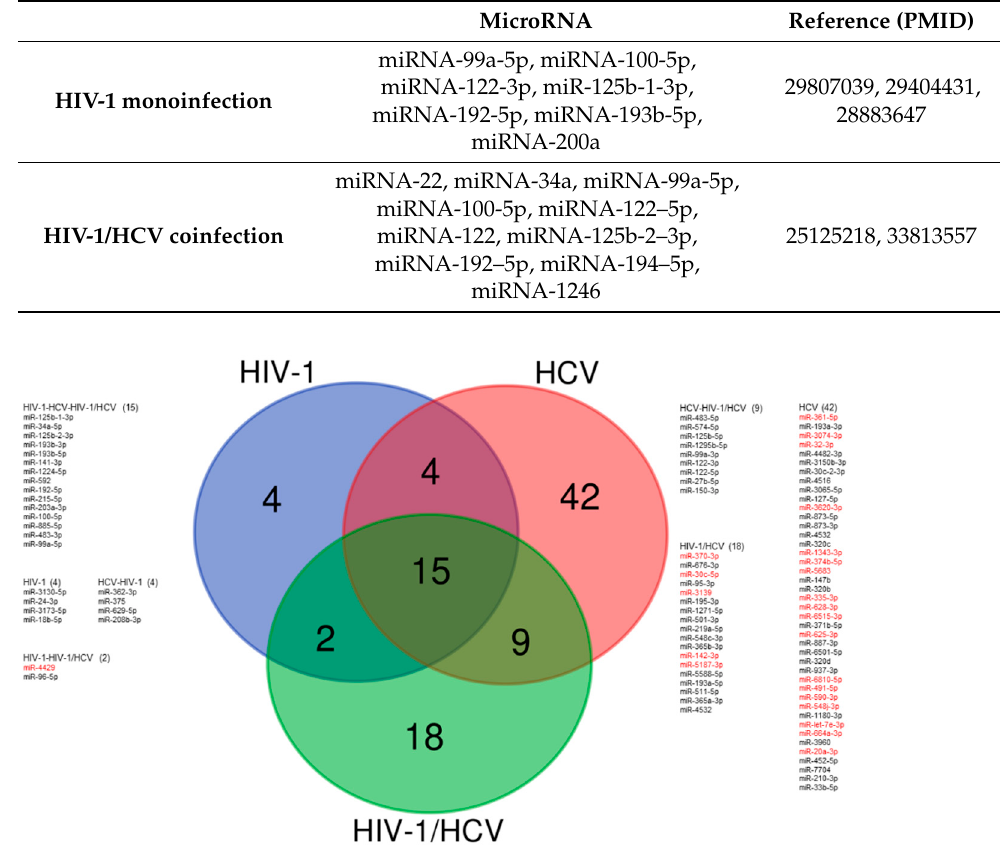
Figure 3. Signatures of deregulated circulating microRNAs in different infected populations. Venn diagram showing circulating plasma miRNAs with significant (fold change > 2 and adjusted p < 0.05) differences between healthy samples ( n = 21) and different infected populations: HIV-1- monoinfected ( n = 53), HCV-monoinfected ( n = 17), and HIV-1/HCV-coinfected ( n = 50). Data were obtained from two studies [65,88]. miRNA profile data were generated by small RNA sequencing of individual plasma samples. Downregulated circulating miRNAs are shown in red and upregulated circulating miRNAs in black.